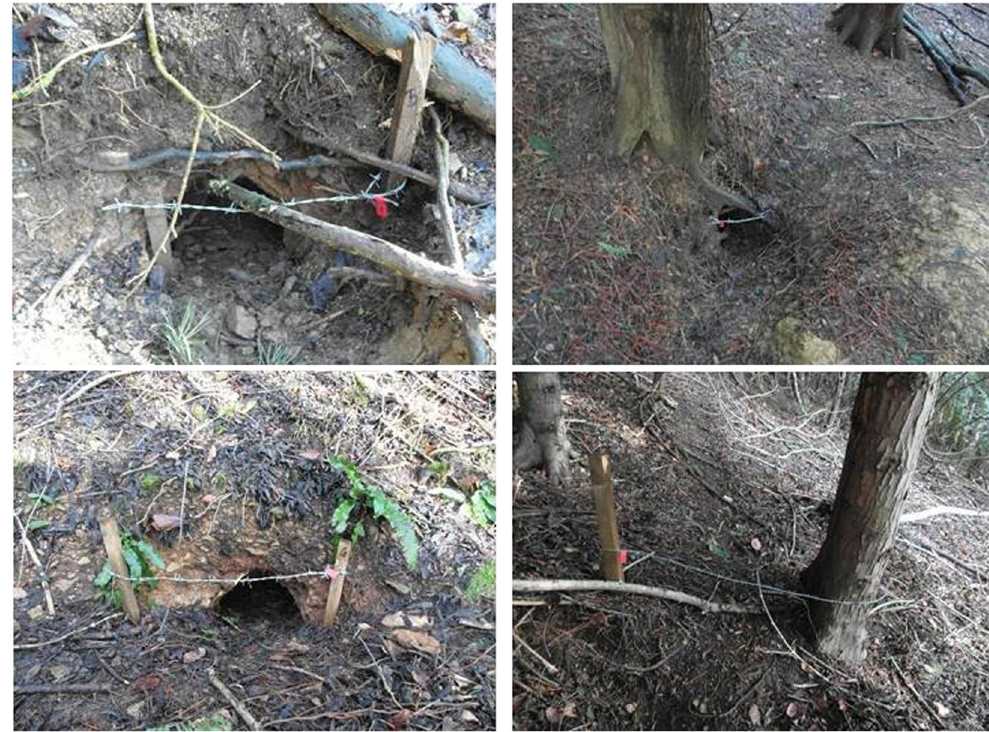
Figure 2. Examples of hair traps in situ over badger sett entrance holes and